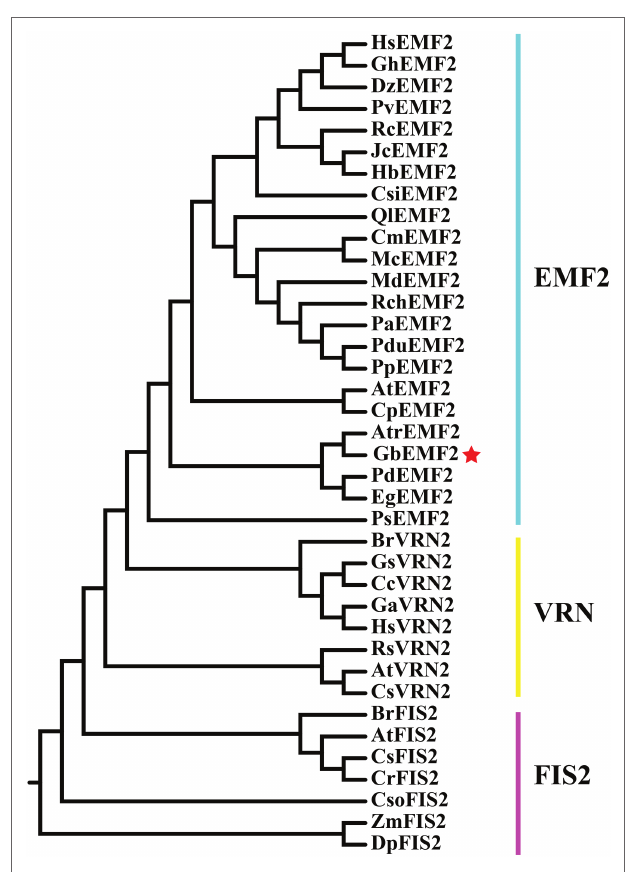
FIGURE 2 | Phylogenetic tree of protein in Su(Z)12 homologous protein family.